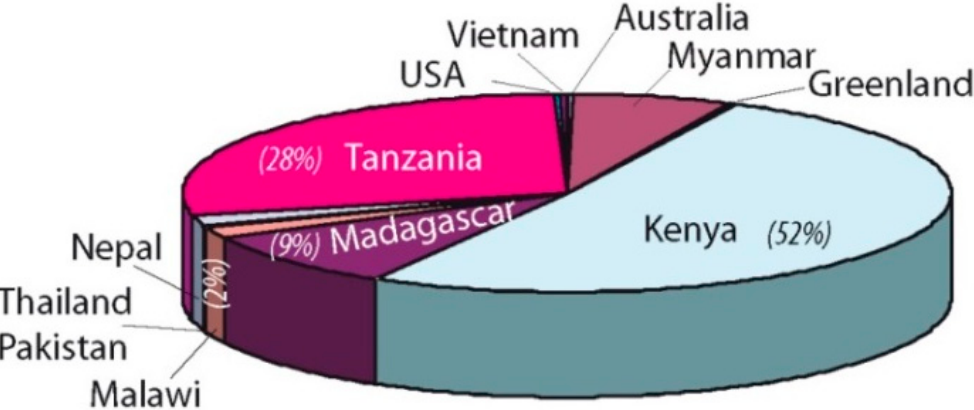
Figure 3. Ruby production worldwide in 2005 showing the production (in %) of some African countries, and others; modified from [28].